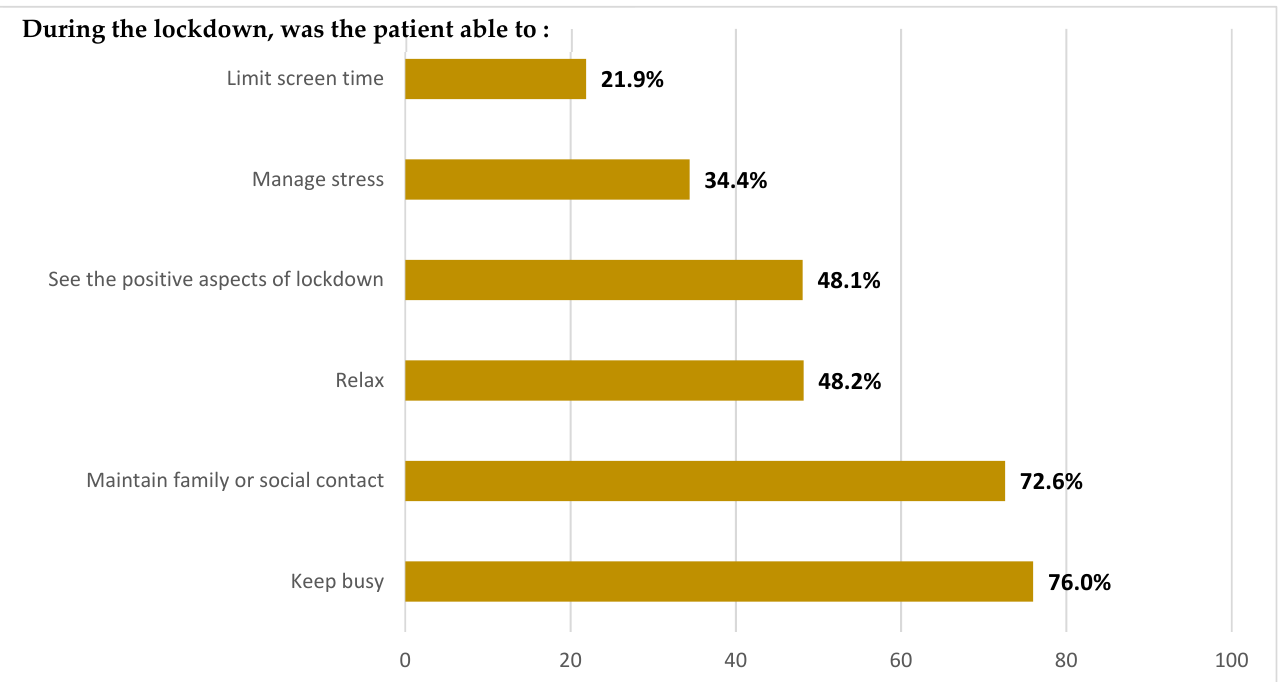
Figure 1. The different positive declarative experiences of lockdown ( n = 893).